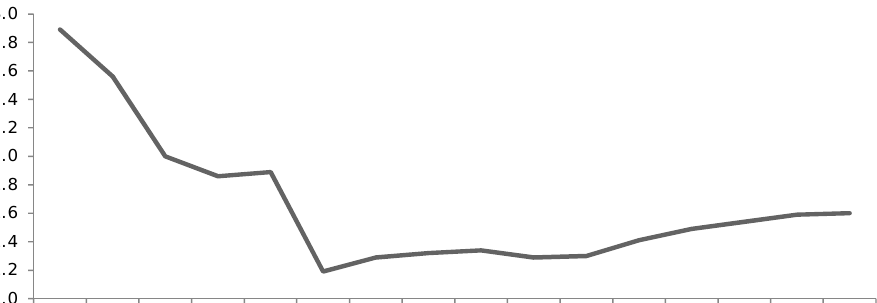
Figure 1. Total fertility rate,